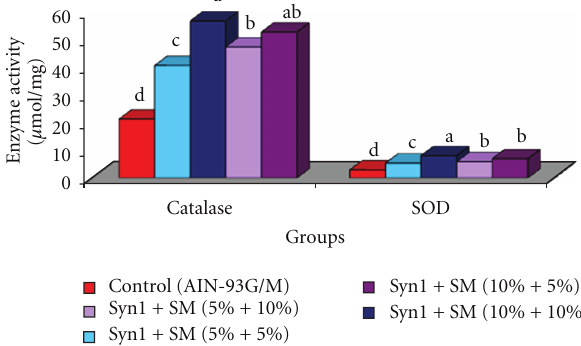
Figure 4: E ff ect of feeding prebiotics and soybean meal on hepatic antioxidative enzyme activities (a) Catalase (b) SOD activity ( μ mol/mg) in F344 male rats. Abbreviations: SM: soybean meal, SOD: Superoxide-dismutase. abcd Bars with same letter are not significantly di ff erent using Tukey’s studentized range test ( P ≤ 0 .